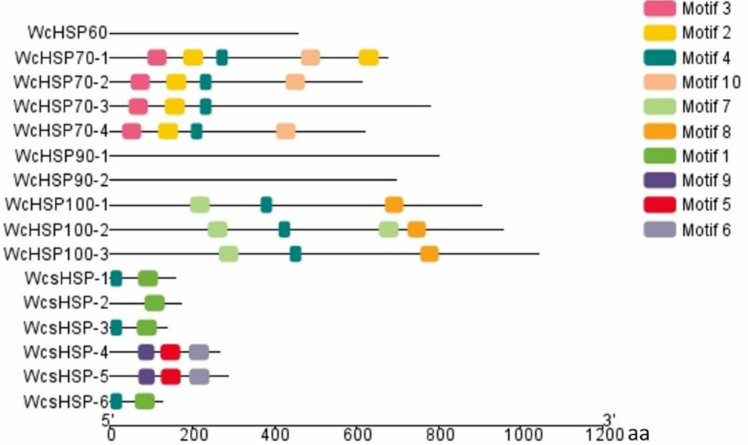
Figure 3. Analysis of conserved motifs of heat shock proteins. Different colors denote different motifs and length of box denotes motif length. ‘aa’ means amino acid.